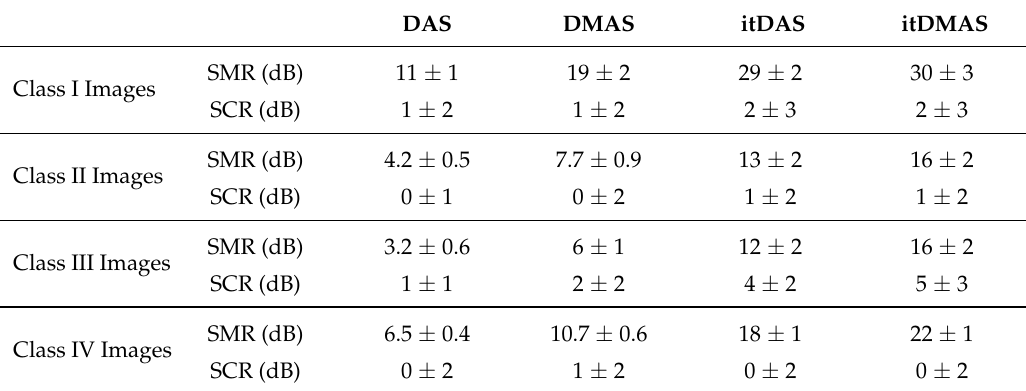
Table 2. Image Quality Metrics of Reconstructions Displayed in Figure